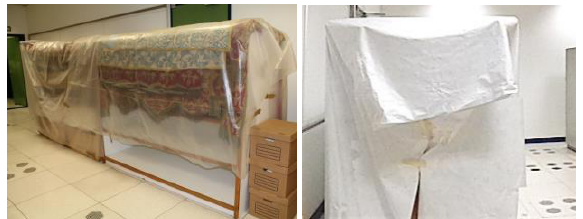
Figure 5 – Storage solution adopted for the seventeen-banner collection, between 2008 and 2018.